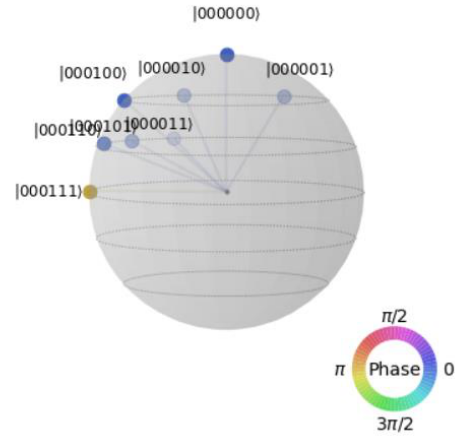
Figure 10. Oracle renderings.